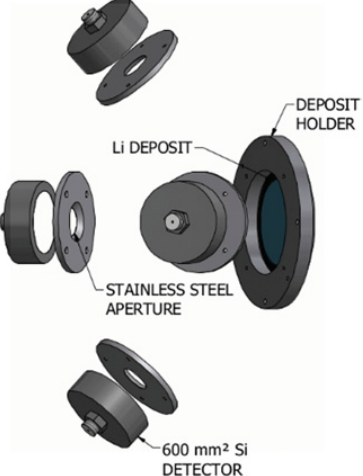
Figure 4. A representation of the layout of the flux monitor used in the BL2